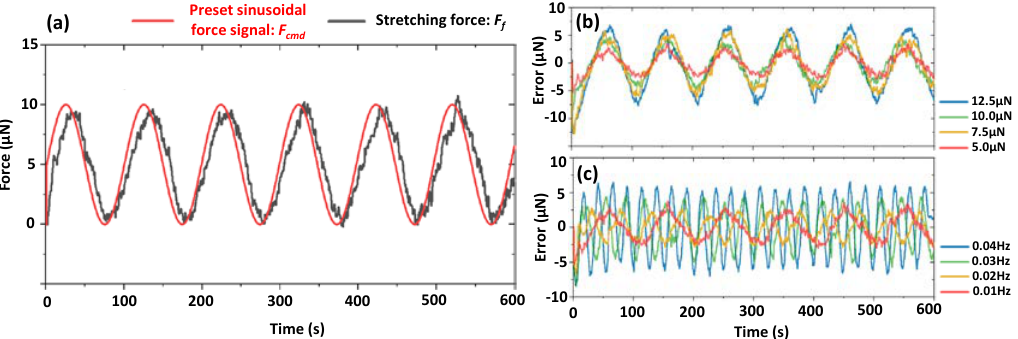
Figure 4. Tracking performance evaluation. ( a ) Time series of F f vs. F cmd ( b ) Time series of sine wave tracking error with different stress amplitudes. ( c ) Time series of sine wave tracking error with different frequencies.